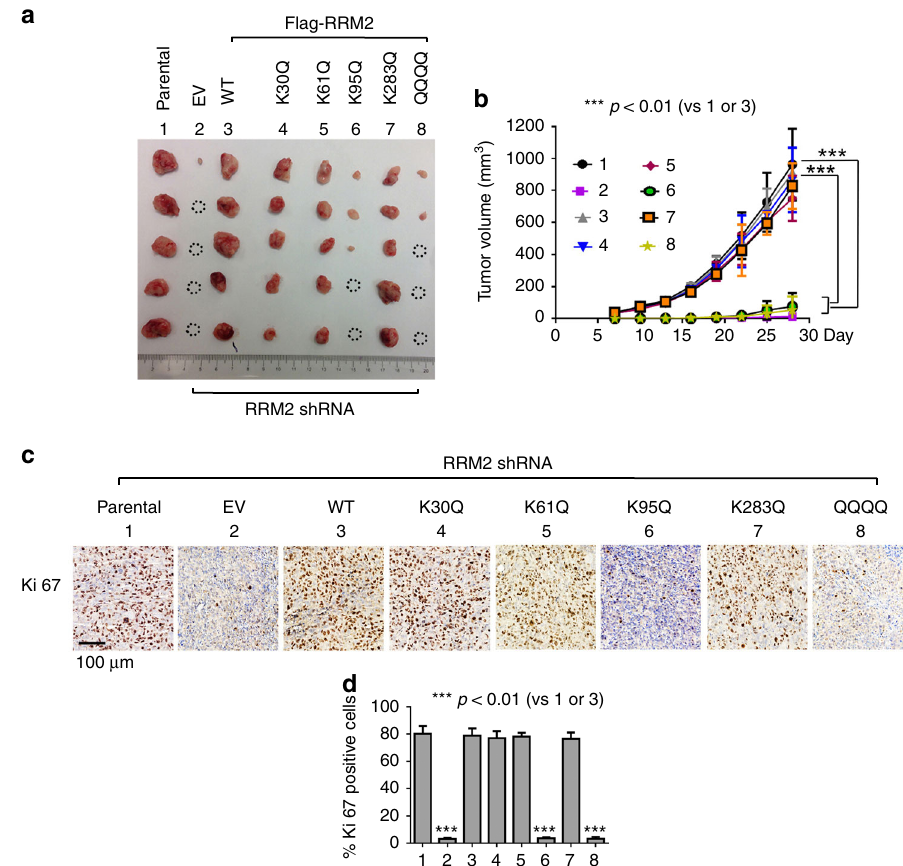
Fig. 9 RRM2 acetylation at K95 suppresses tumor growth in vivo. a , b The same number (3 × 10 6 ) of H1299 parental cells or RRM2-de fi cient H1299 cells expressing empty vector, Flag-tagged WT, or individual acetyl-mimetic RRM2 mutant(s) were injected into subcutaneous tissue at the fl ank region of nude mice to generate lung cancer xenografts ( n = 5 mice each group). Tumor volume was measured once every 4 days. After 28 days, the mice were killed and the tumors were removed, photographed, and analyzed. All dotted circles in tumor images indicate no visible tumors. The error bars indicate ± s.d., n = 5 per group. *** P <0.001, by two-tailed t test. c , d IHC staining of Ki67 was performed in tumor tissues at the end of experiments. Scale bar: 100 μ m. The error bars indicate ± s.d., n = 5 per group. *** P <0.001, by two-tailed t